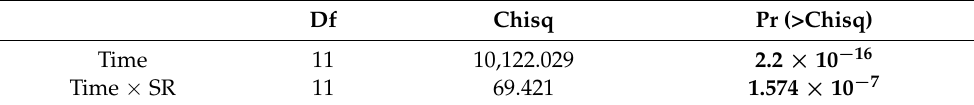
Table 1. Type II analysis of variance table with Kenward–Roger’s method showing the results with the fixed-effects part of the mixed-effects models considering the effects of plant species richness (‘SR’) on the total volume over the growing season (“Time”). Restricted maximum likelihood estimated the variance components of the mixed effect models. Values in the columns are numerator degrees of freedom (Df), chi-square test (Chisq), and p -values (Pr (>Chisq)). Significant relationships at level 0.05 are in bold.